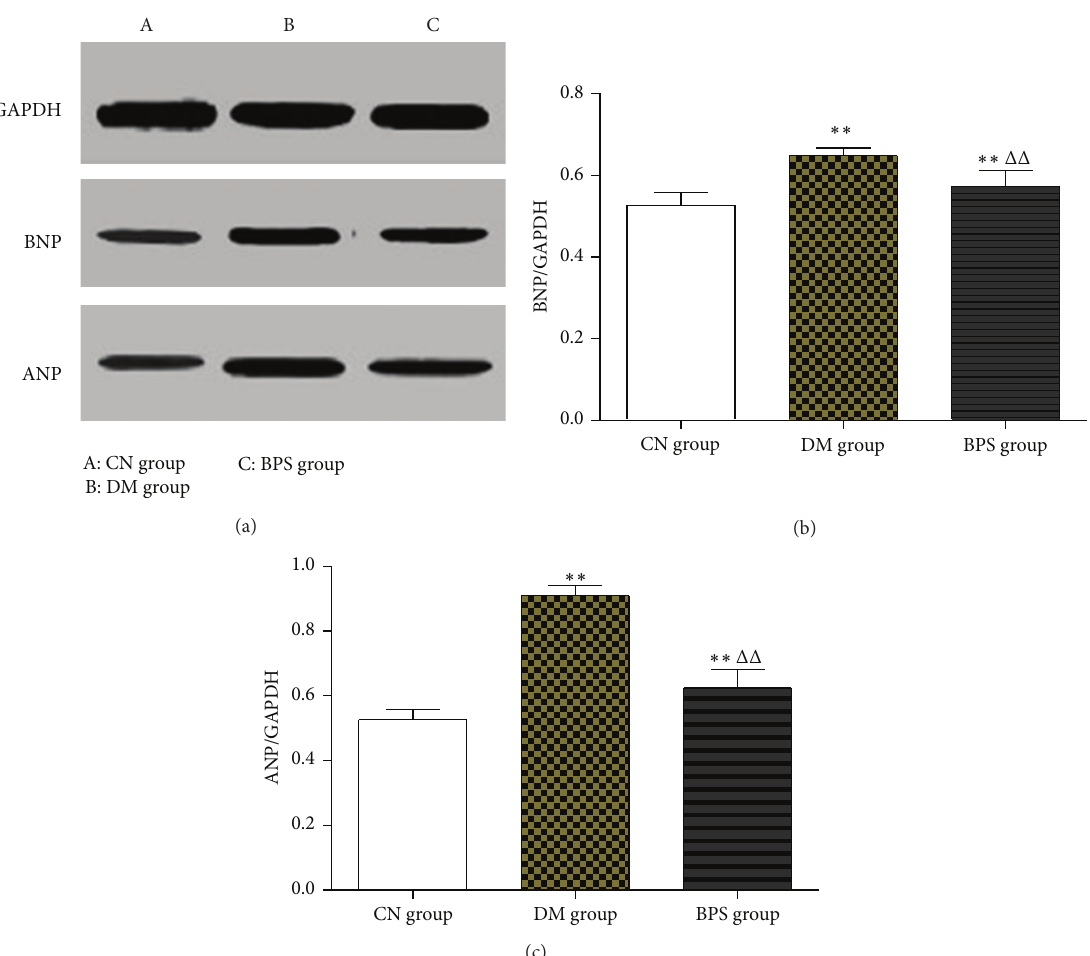
Figure 13: Expression levels of myocardia-associated hormone proteins. Compared with the CN group, the expression of the BNP and ANP proteins in the myocardial tissues of rats in the DM and BPS groups significantly increased ( 𝑃 < 0.01 ). Compared with the DM group, the expression of the BNP and ANP proteins in the BPS group significantly decreased ( 𝑃 < 0.01 ).